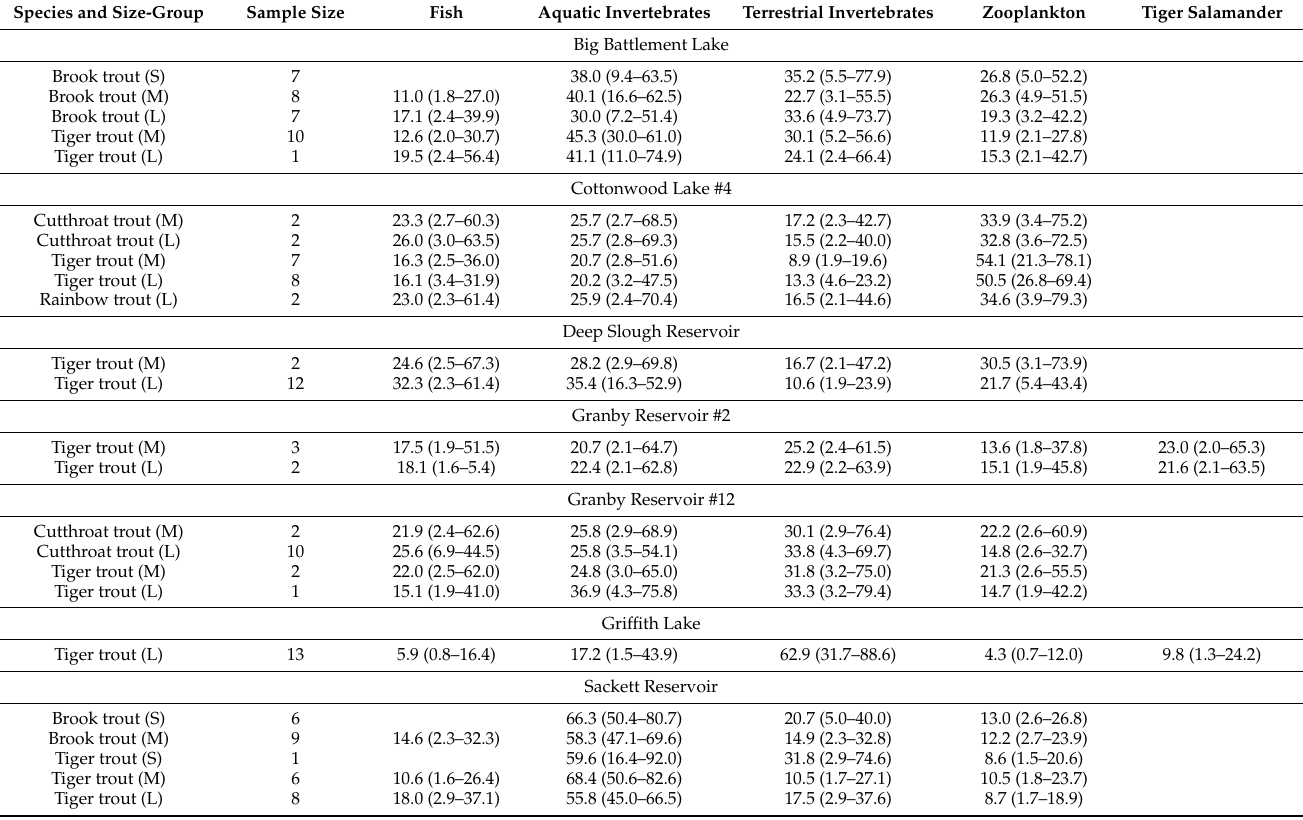
Table 5. Diet compositions of different size-groups of trout encountered during 2017 field sampling. Estimates (mean % and corresponding 95% credible interval in parentheses) for different prey sources were derived using Bayesian stable isotope mixing models. The letter “S” stands for small fish (<150 mm TL), “M” for medium (150–249 mm TL), and “L” for large ( ≥ 250 mm